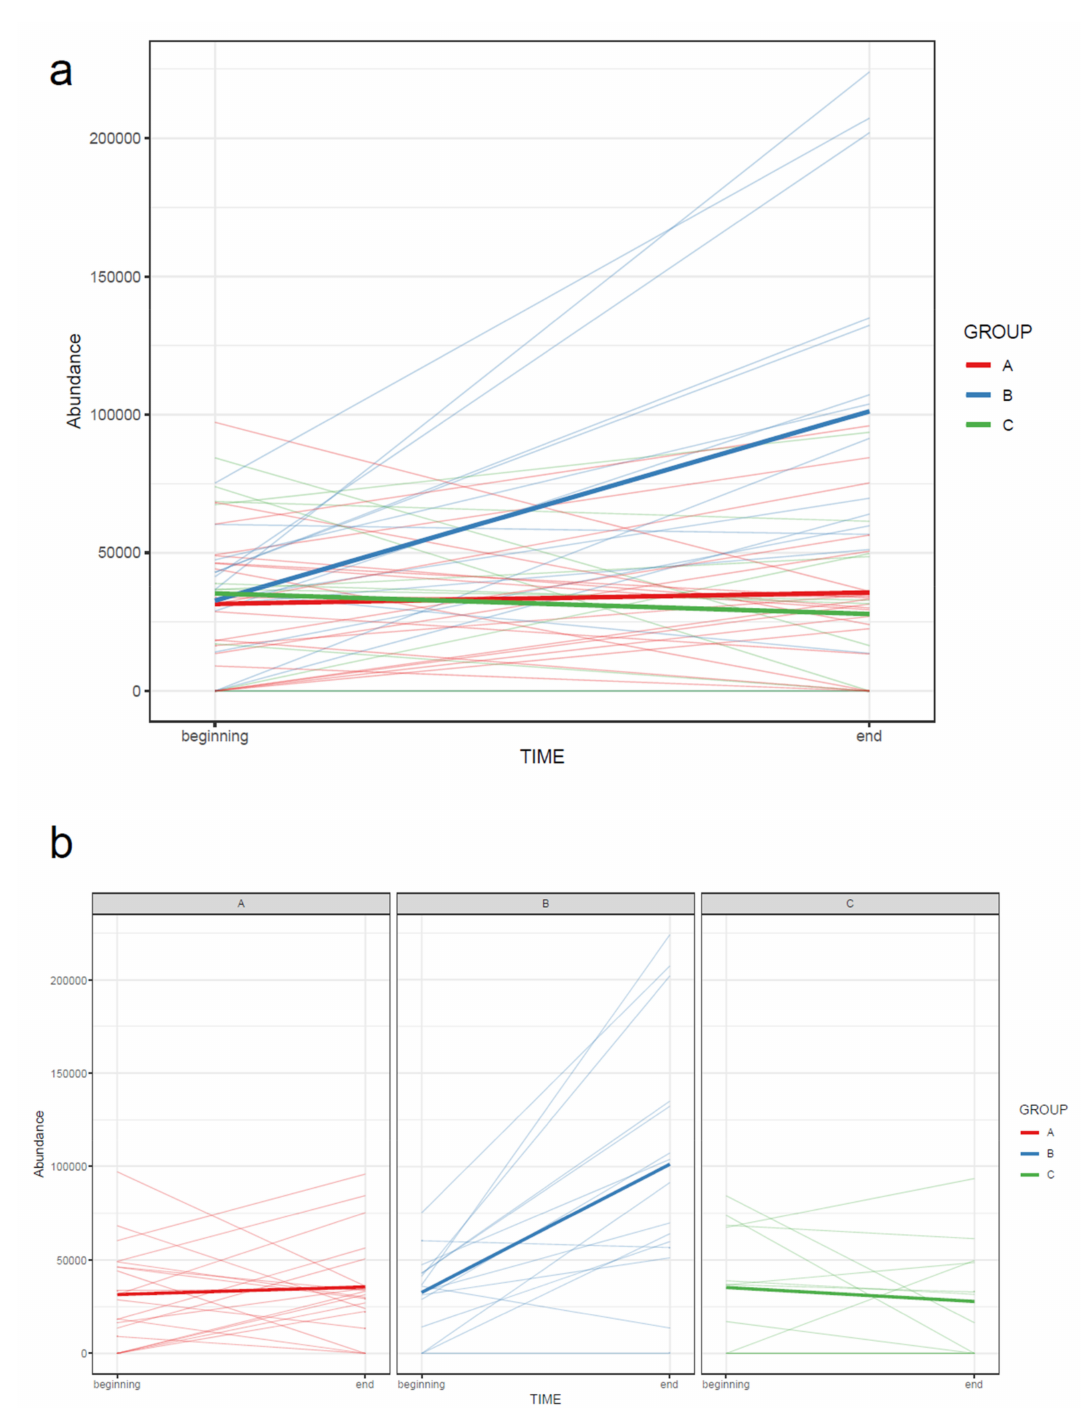
Figure 17. The change in abundance of a molecular feature between two time points in each subject, colored by group ( a ). Data with time series from multiple groups is easier to read when divided to small multiples ( b ). The bold lines represent group means. Note that the bold mean lines do not necessarily reflect an overall trend present in each